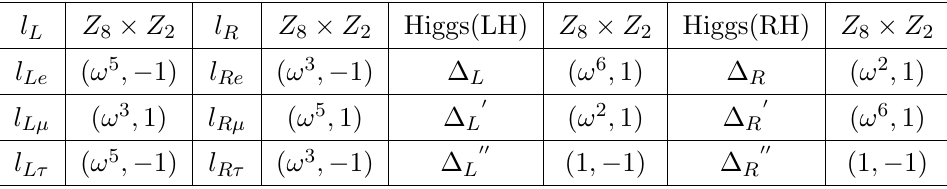
Table 4 . Particle assignments for B2.